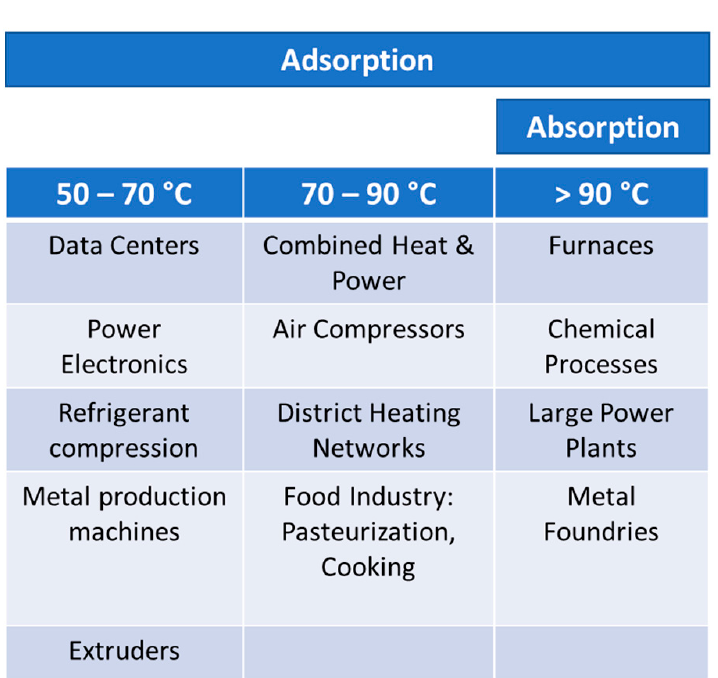
Figure 2. Application fields for waste heat driven ab/adsorption chillers.